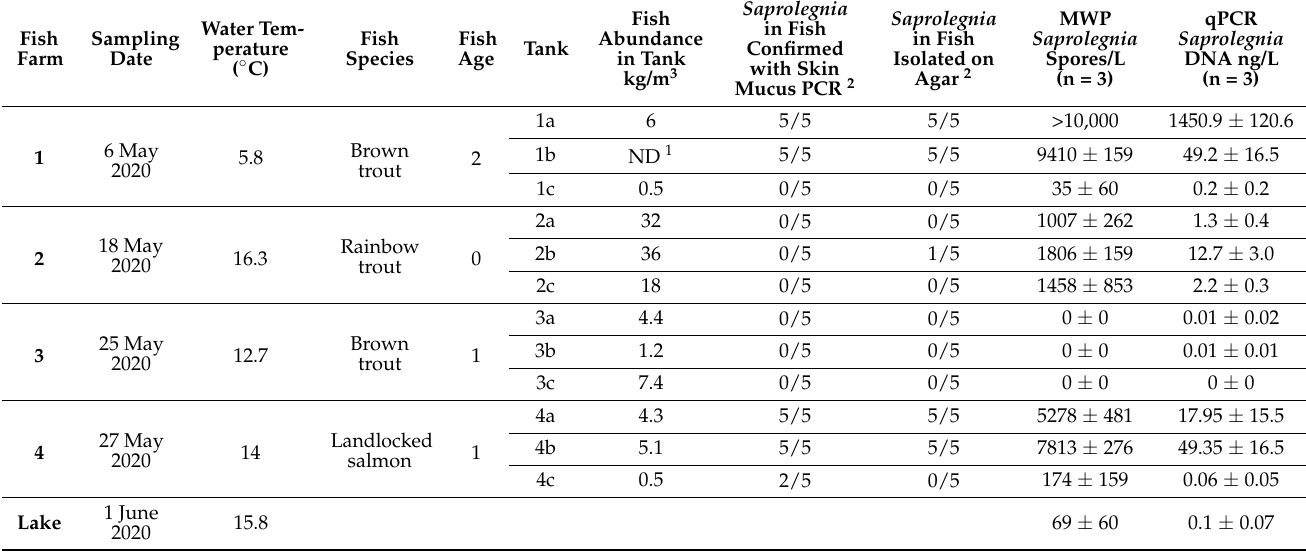
Table 4. Details of sampling and results from four fish farms, from which fish and water were sampled and examined for the presence of Saprolegnia . A lake water sample was included as a reference. Sampling date, water temperature and sampled fish and age in each farm is included. Samples were taken from three tanks in each fish farm (a–c), where fish abundance in each tank was determined. Saprolegnia in fish mucus samples were compared by PCR and agar methods. The average and standard deviation ( ± SD) were calculated for each tank water sample from 3 replicate 96-well plates with microwell plate (MWP) enumeration or from three filtrations withqPCR assay.